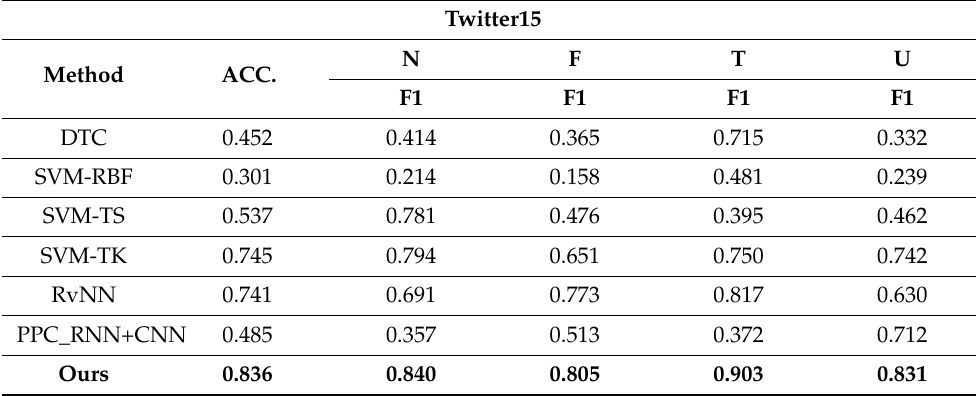
Table 4. Rumor detection results on Twitter15.